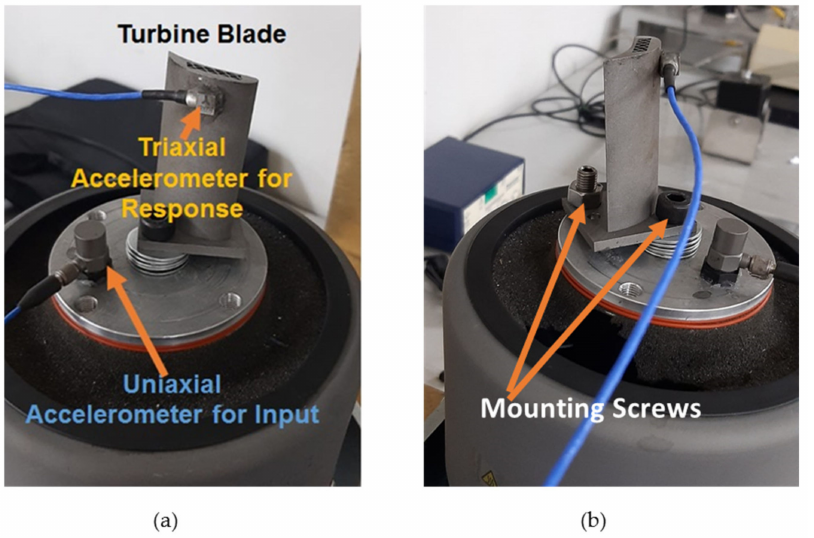
Figure 4. Setup for vibration fatigue testing.